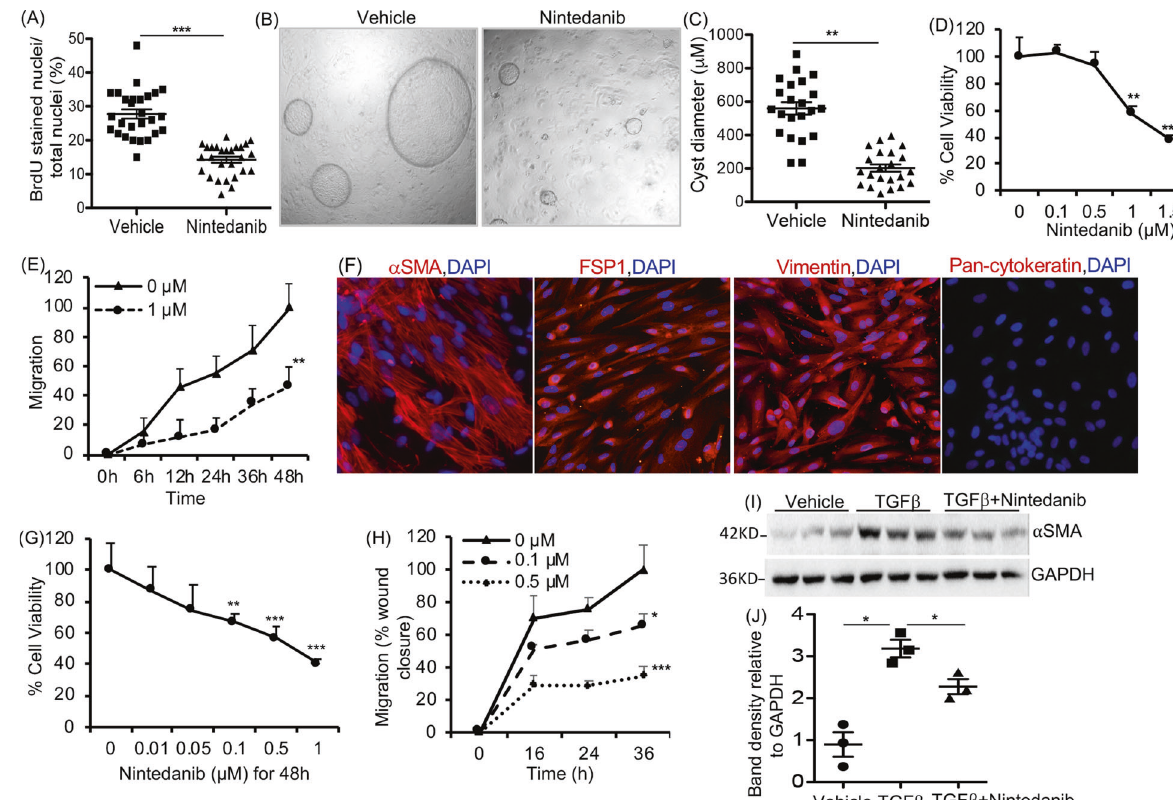
Fig. 1 Effect of Nintedanib treatment on ADPKD renal cystic epithelial cells and myo fi broblasts. A BrdU-incorporation assay in human ADPKD renal cystic epithelial cells treated with nintedanib (1.5 µM for 24 h). n = 4 biological replicates (patient samples) and seven technical replicates each. B Images of microcyst growth in 3D collagen matrix by human ADPKD renal cystic epithelial cells treated with vehicle or nintedanib (1.5 µM) for 12 days. 1X magni fi cation, and ( C ) quantitation of cyst diameter. n = 4 biological replicates and 5 or 6 technical replicates each. D Human ADPKD renal myo fi broblasts treated with nintedanib for 48 h. MTT assay and E migration (% wound closure in a scratch assay) in the presence of 0 or 1 µM nintedanib. n = 4 biological replicates and three technical replicates each for D and E . F Human renal ADPDK myo fi broblasts immunostained for α SMA, FSP1, vimentin, or pan-cytokeratin. G NRK-49F rat renal fi broblasts treated with nintedanib for 48 h. MTT assay. n = 7. H Migration of NRK-49F cells treated with nintedanib n = 4. I Immunoblot of NRK-49F cells incubated with TGF β (2 ng/ml) and nintedanib (1.5 μ M) for 48 h and ( J ) quantitation of band density. * P < 0.05 ** P < 0.01, *** P < 0.001, vs vehicle or 0 µM